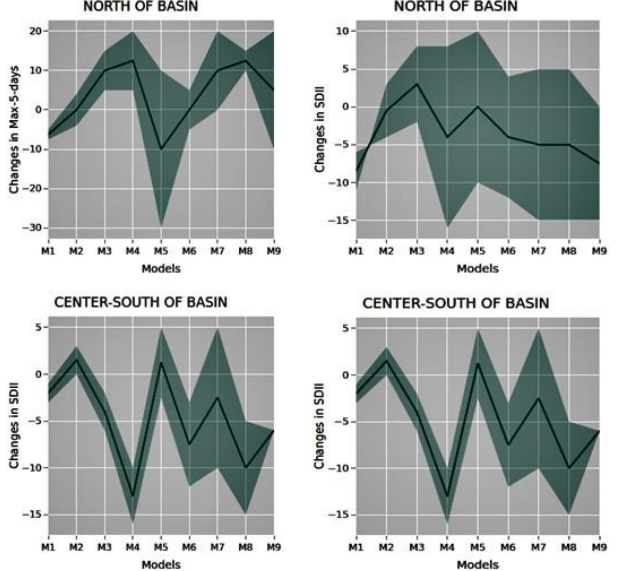
Figure 4. Max 5d precipitation andsimple daily intensity in- dex changes (in %) between far future (2071–2100) and histor- ical period (1971–2000) during May to September for models: (M1) CNRM-CM5, (M2) MIROC5, (M3) EC-EARTH, (M4) IPSL- CMA5-MR, (M5) MPI-ESM-LR, (M6) GFDL-ESM2M, (M7) NorESM1-M, (M8) CanESM2 and (M9) Models-Mean (ensemble mean of